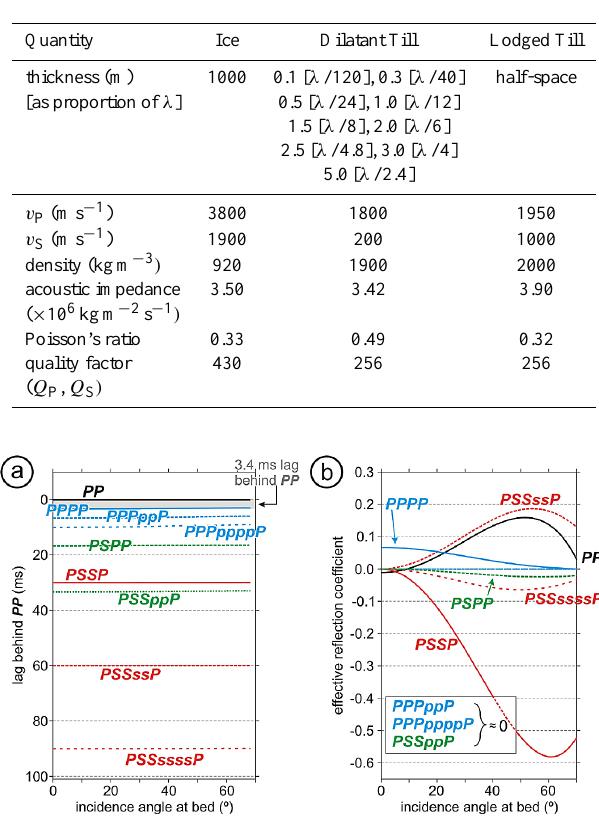
Table 2. Ice and till properties as used in “SKB2” forward- modelling of seismic data (with reference to Vaughan et al., 2003; Peters et al., 2008). Ice properties are fixed throughout, and S-wave quality factors are equated to reference values for P-waves. Nine thicknesses of dilatant till are simulated, from 0.1m ( λ /120) to 5.0m ( λ /2.4).